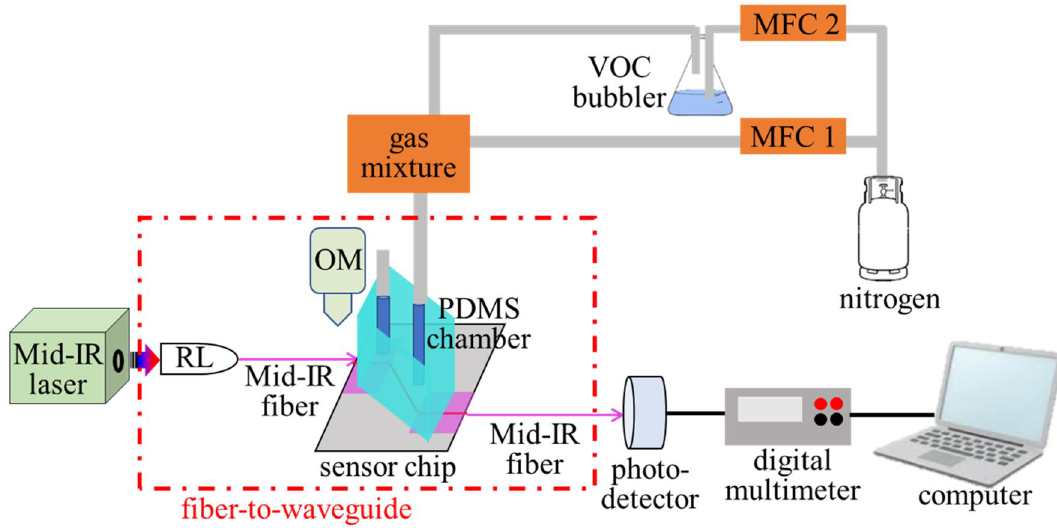
Figure 2. Experimental setup of the VOC detection measurement. Mid-IR probe light from the laser was coupled into the waveguide using a butt-coupling method. The guided light was collected by another fiber after the waveguide end-facet. VOC vapor was carried by N 2 . The flow rate the VOC concentration were controlled by the MFCs.